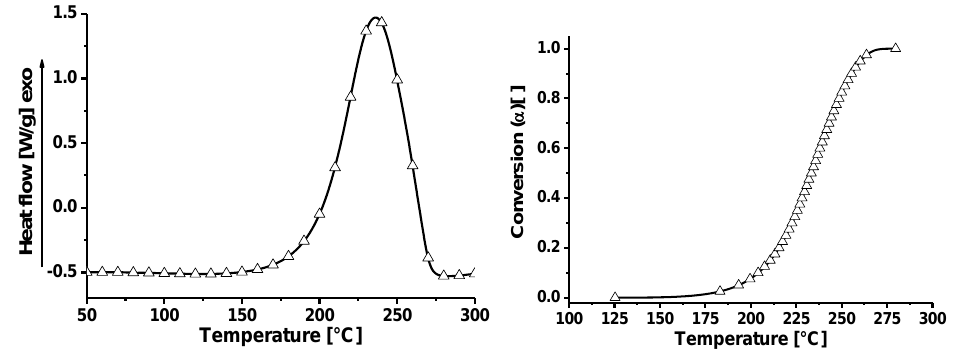
Figure 8. Non-isothermal DSC enthalpy for the epoxy matrix ( a ); variation of the fractional conversion ( α ) as a function of temperature for the epoxy matrix ( b ).